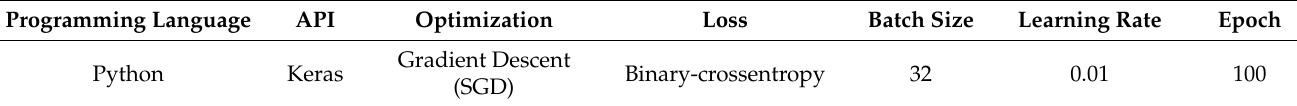
Table 4. Main information of configuring the model for